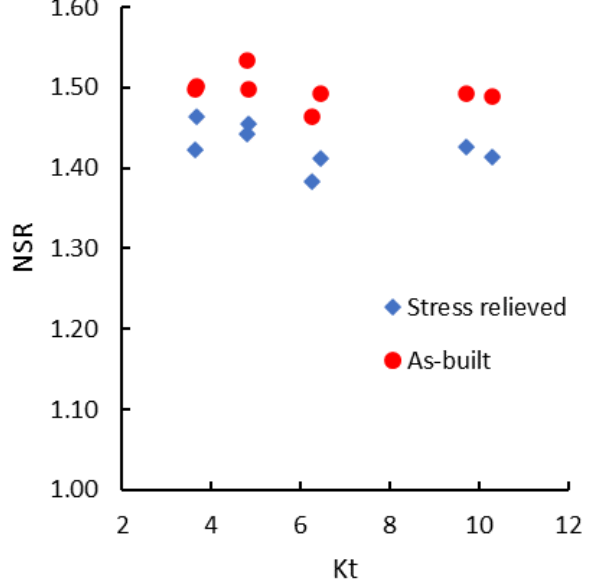
Figure 6. Notch strength ratio vs. the coefficient of stress concentration.